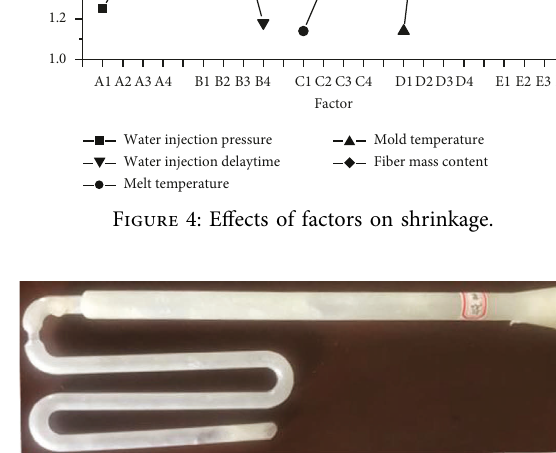
Figure 5: The OWAIM specimen.